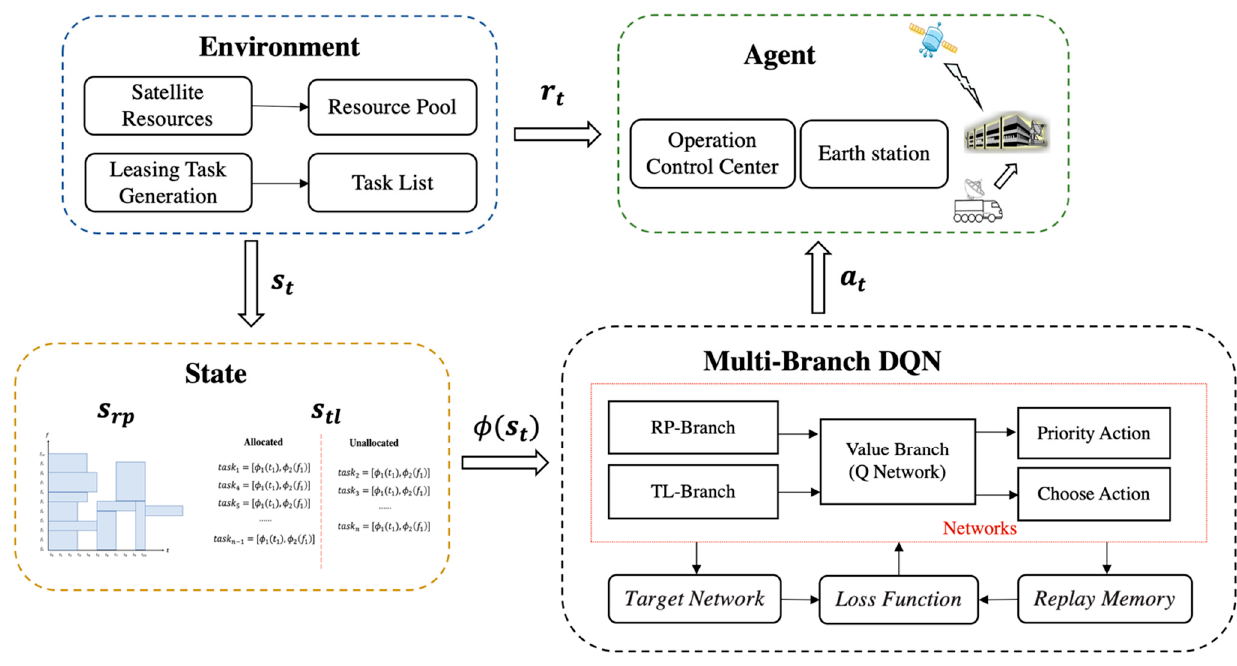
Figure 3. Overview of the proposed Multi-Branch DQN-based resource allocation method.